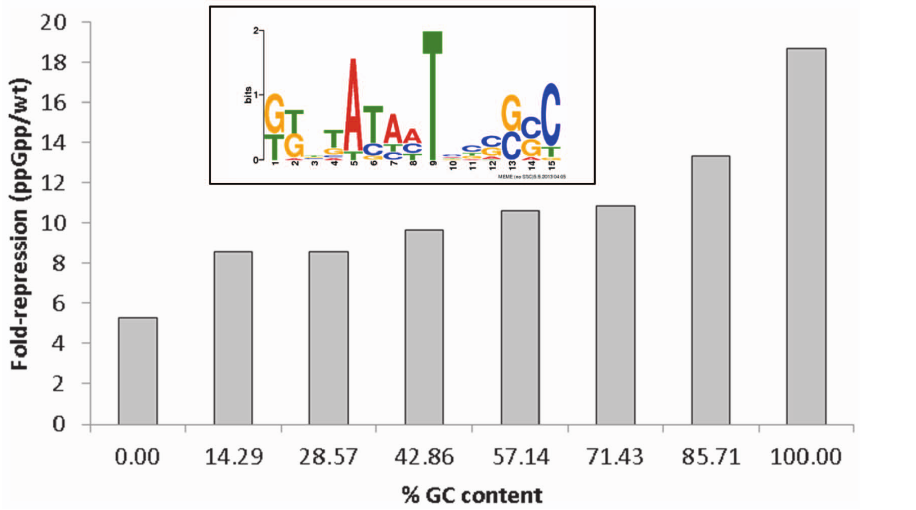
Figure 6. Correlation of ppGpp-repression of LSP TSSs of annotated genes with %GC content of discriminator regions. The analysis of GC content within the discriminator region was calculated using a custom Perl script. The inset shows the GC rich conserved region identified using MEME within the discriminator regions of promoters that were ppGpp-repressed by 20-fold or greater.